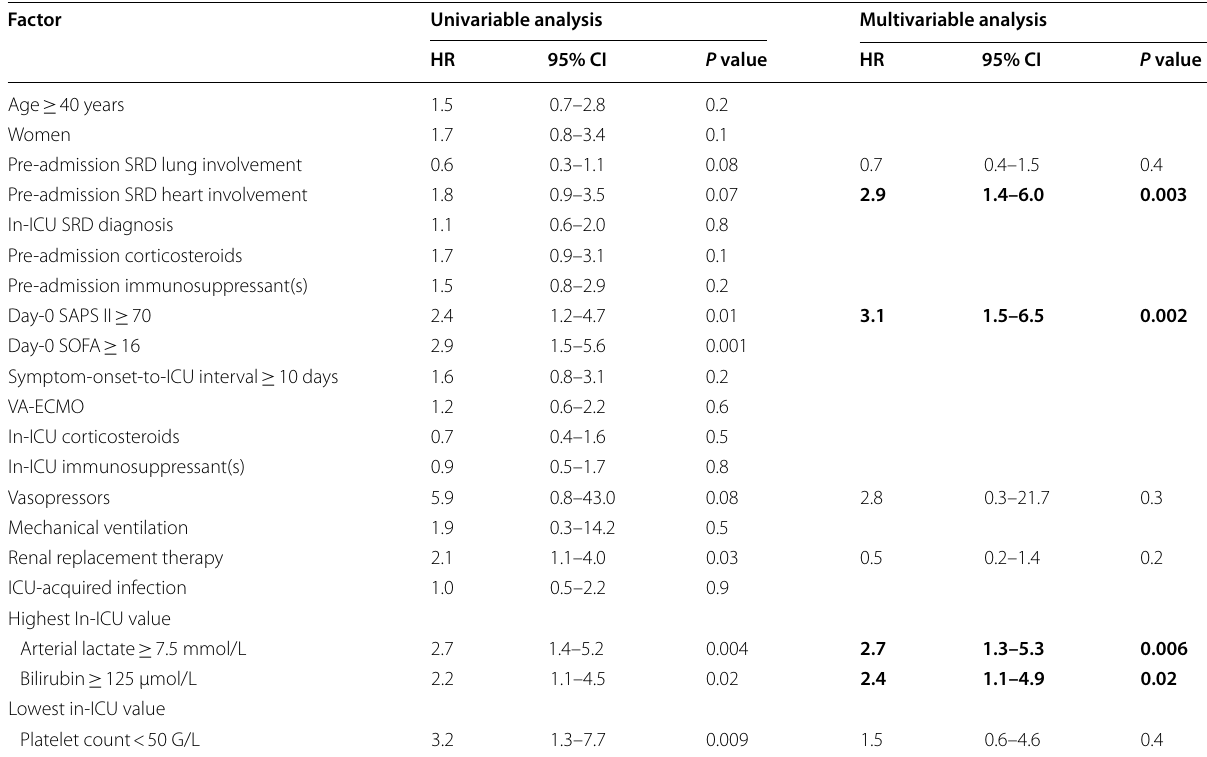
Table 5 Univariable and multivariable analyses of factors associated with in-hospital mortality of the 69 ECMO-treated SRD flare